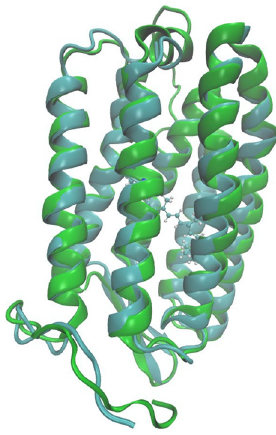
Figure 2. The predicted structure of archaerhodopsin-3 (green) superimposed on crystallographic structure of archaerhodopsin-1 (blue).